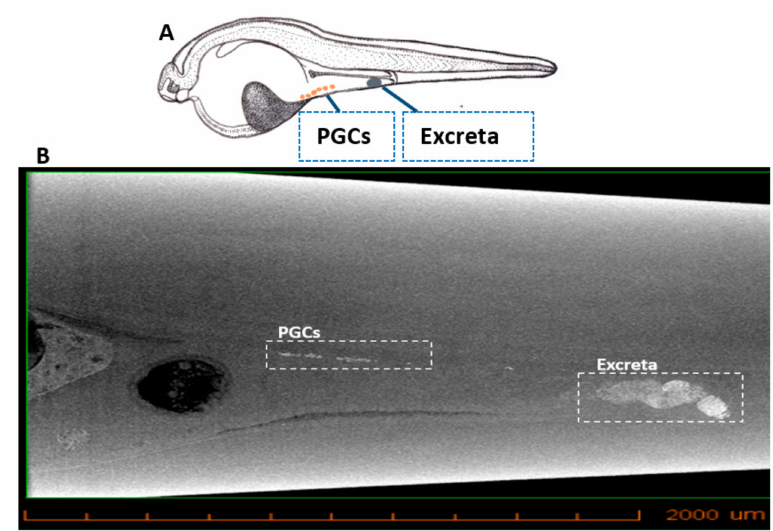
Figure 3. X-ray microtomographic (Micro-CT) section of sturgeon larvae after injection with IONs. ( A ) Illustration showing the position of IONs delivered into PGCs and excreta in sturgeon larvae. ( B ) Micro-CT shows the position of PGCs (in whit dotted box) during their migration towards the position where gonads are formed. Excreta of larvae can also be seen in the white dotted